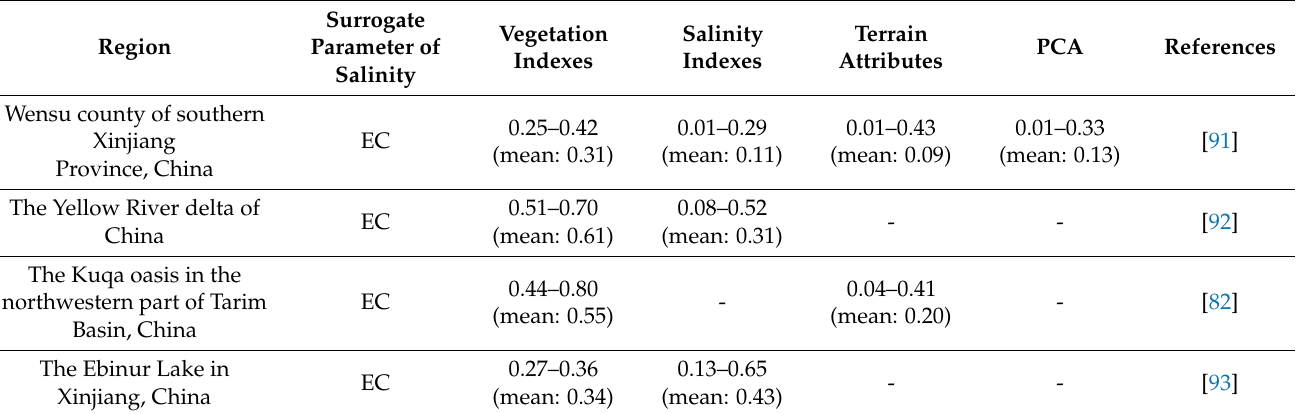
Table 7. The absolute value of correlation coefficients between soil EC and land surface parameters of different